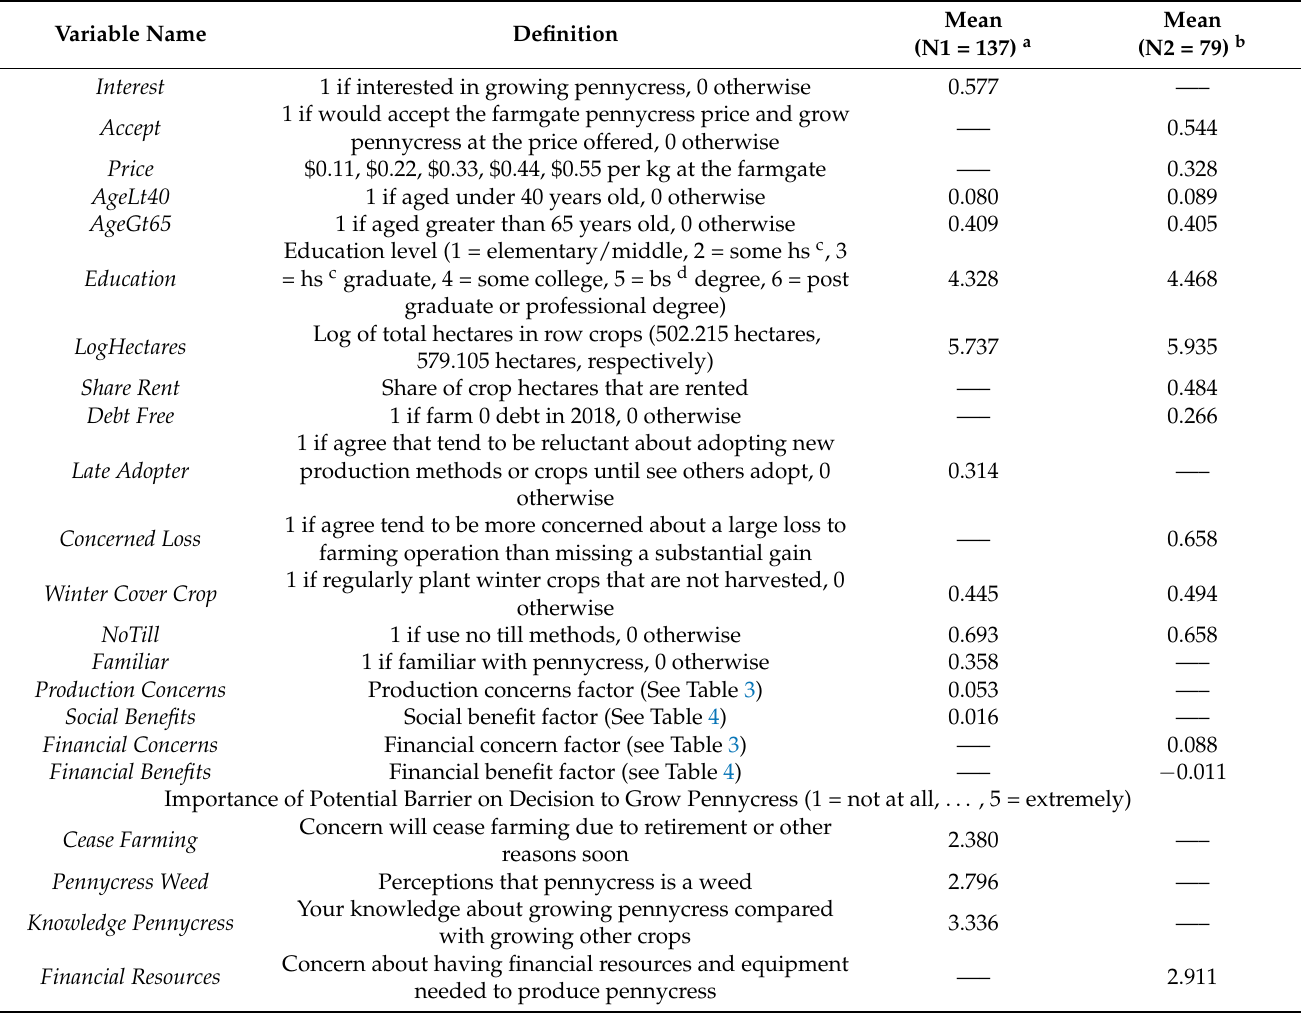
Table 2. Variable names, definitions, and means for variables used in the probit model with sample selection for interest in and willingness to accept the price bid to grow pennycress among row crop farmers surveyed in seven US